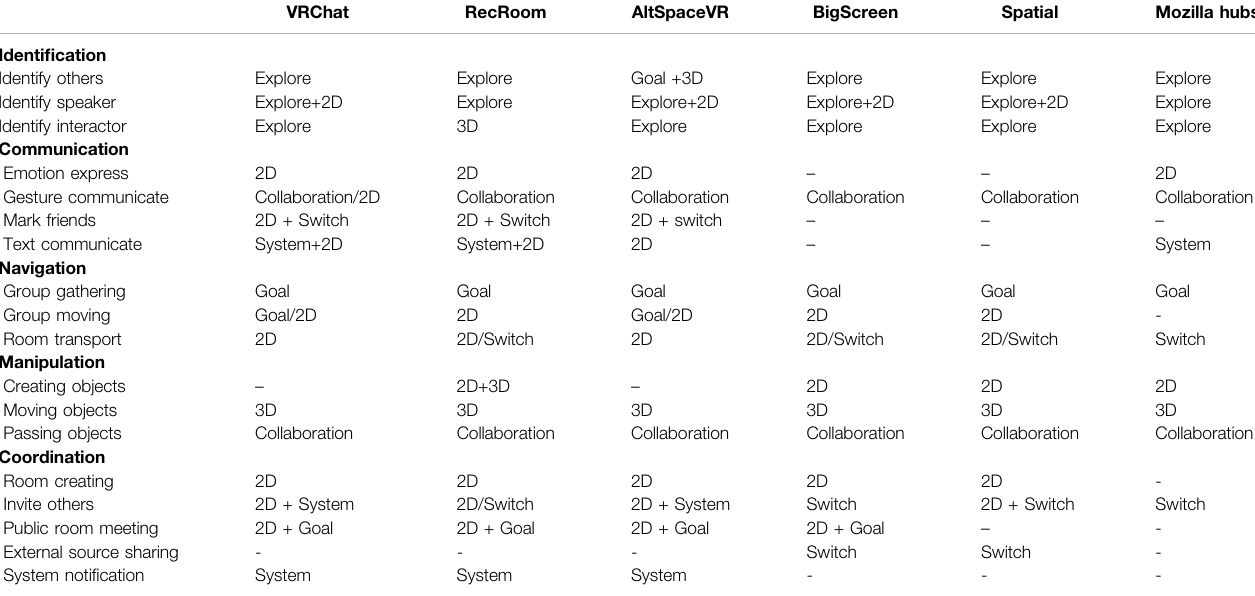
TABLE 2 | The full set of tasks within each of fi ve main task groups (left column), and which interaction cycle they use for each